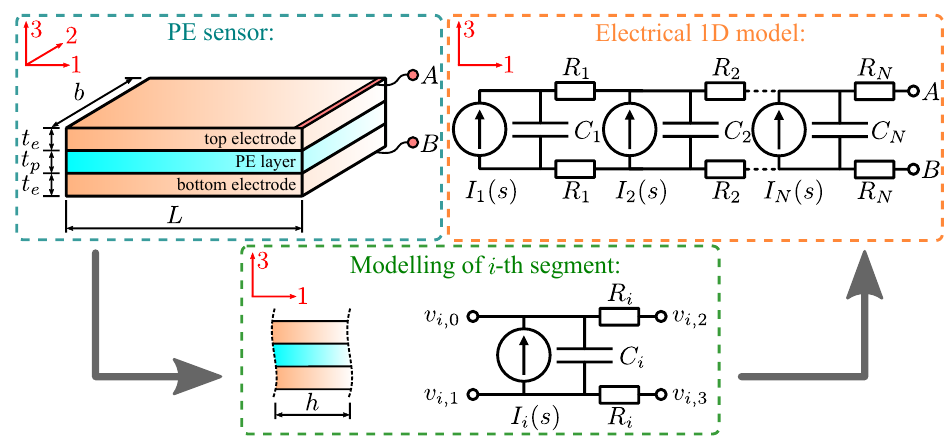
Figure 3. The 1D electrical model of the piezoelectric 3D printed